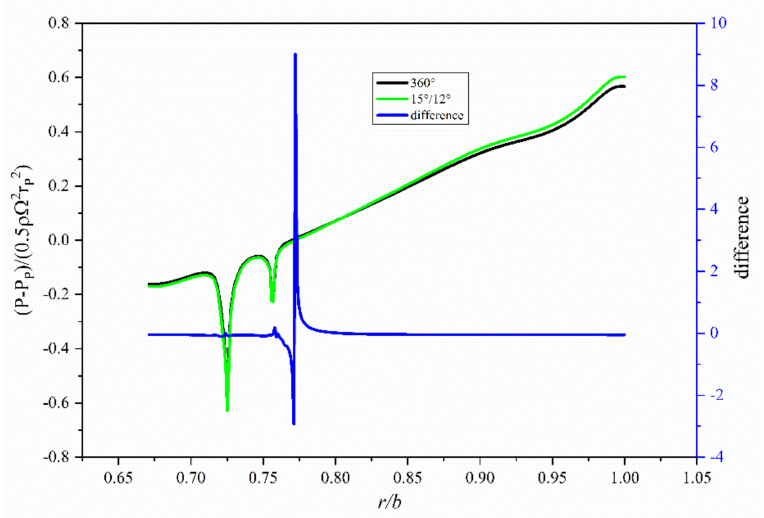
Figure 7. Profile of static pressure near stator for different